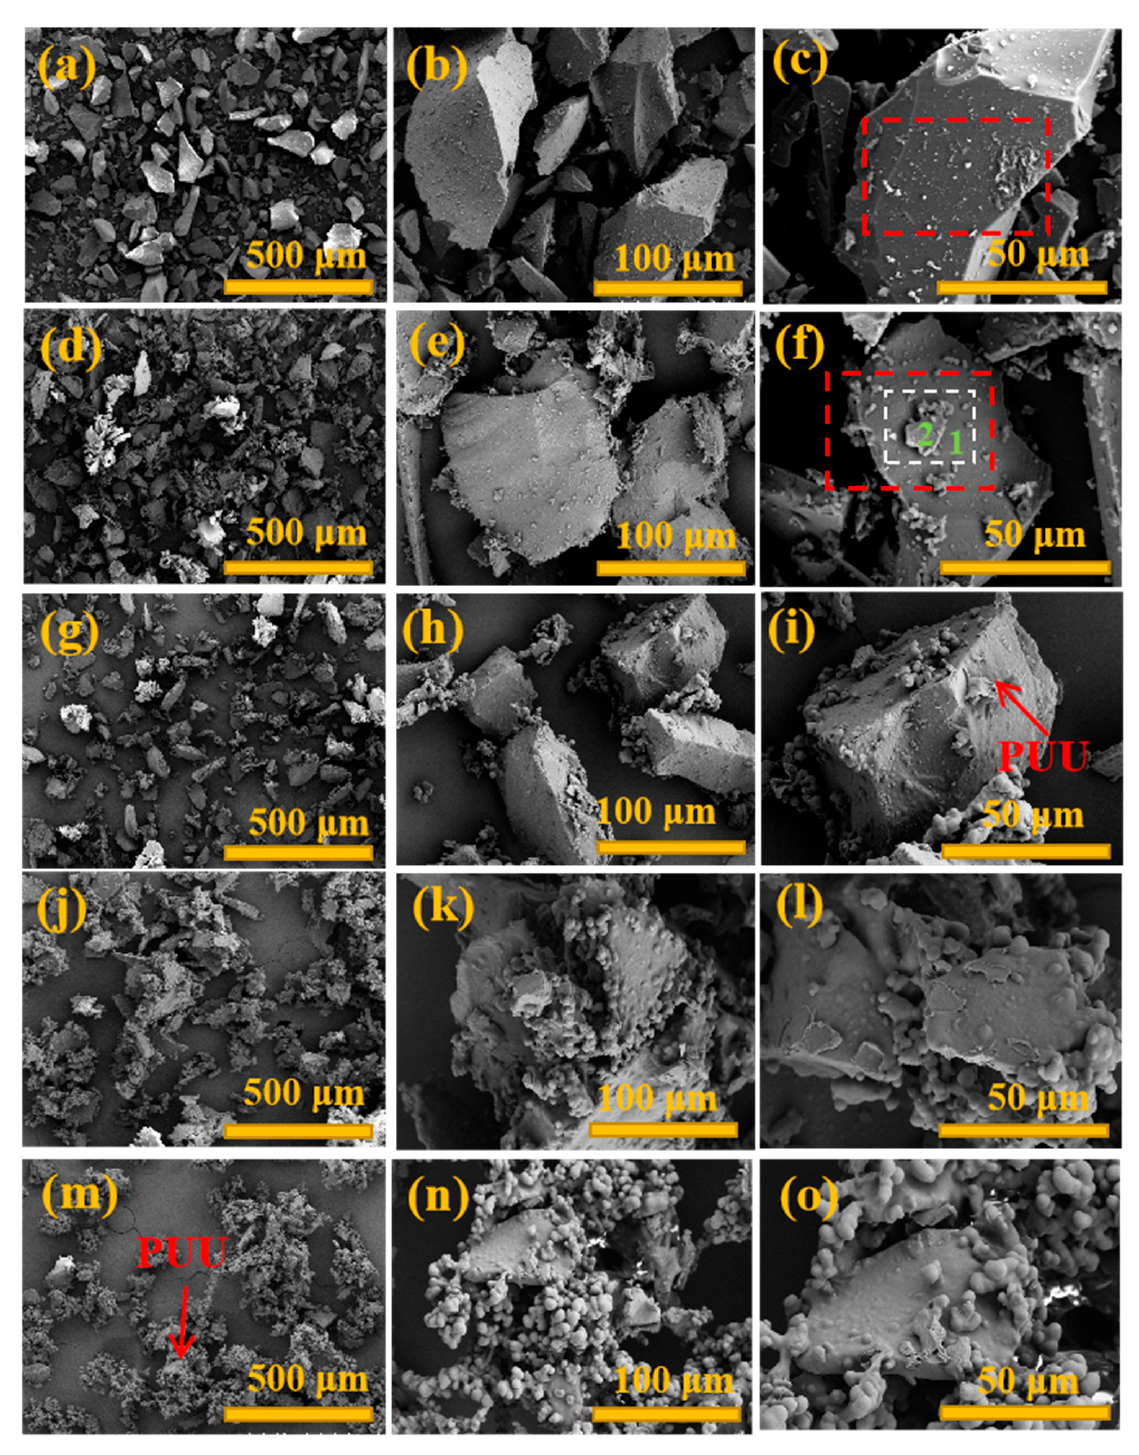
Figure 5. The SEM images of FSP ( a – c ); FSP@PUU-1 ( d – f ); FSP@PUU-2 ( g – i ); FSP@PUU-3 ( j – l ); FSP@PUU-4 ( m – o ).